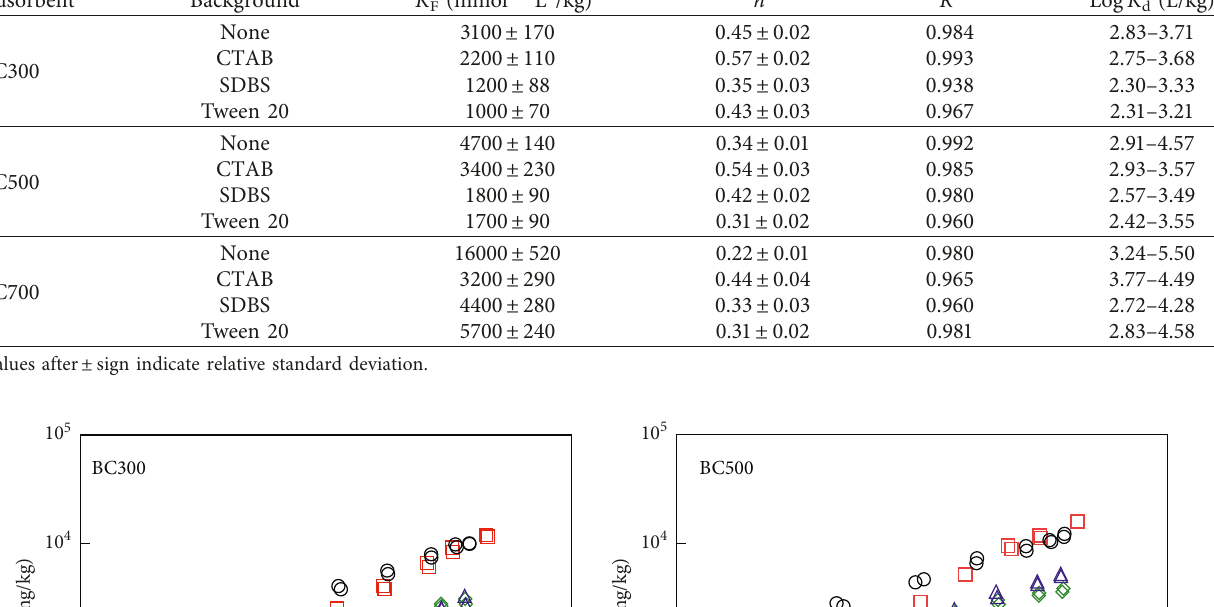
F and n ) and distribution coefficients (K d )) obtained from